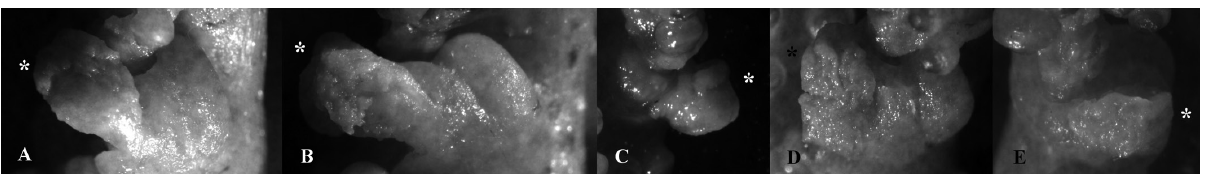
Fig . 8. – Shape variations of the dorsal tubercle of Sepiola bursadhaesa n. sp. male copulatory apparatus. An asterisk ( * ) marks the tubercle. A to E correspond to paratypes MNCN 15.06/226P4, 15.06/226P5, 15.06/226P6, 15.06/226P8 and 15.06/226P9, respectively. A, B and D, copulatory apparatus viewed from the oral-outer lateral side; C, copulatory apparatus viewed from the inner lateral side (only the tubercle is visible); E, copulatory apparatus viewed from the oral side (the ventral row stalks are in shadow).